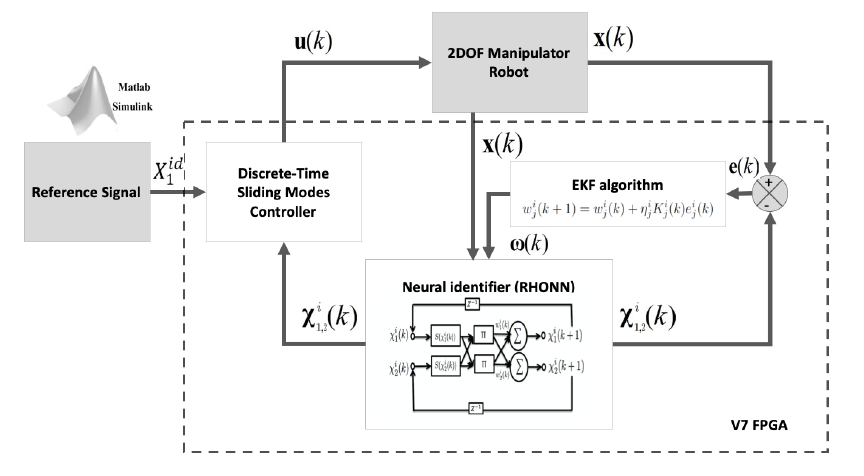
Figure 1. Block diagram of proposed control